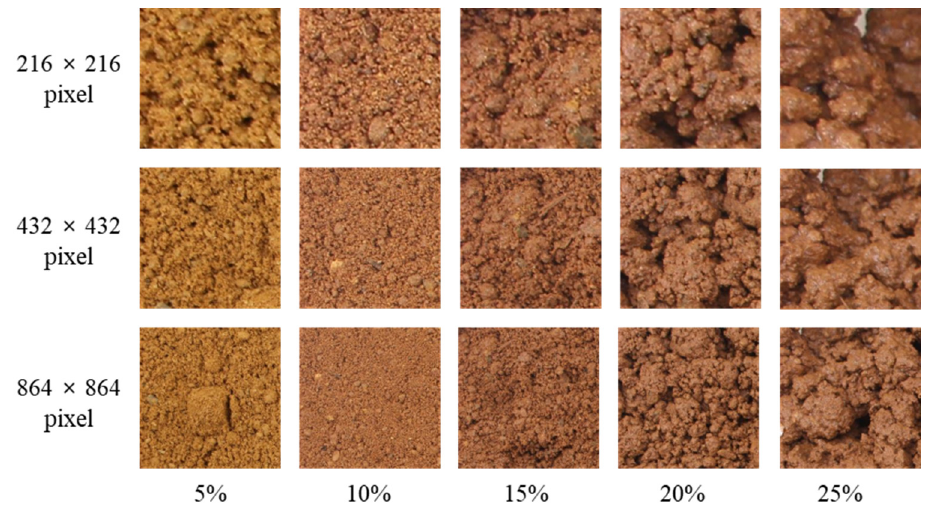
Figure 5. Sample segmented soil surface images under different soil water content conditions. Each image is a cropped image with 3 different sizes from the original soil surface image with a resolution of 5184 × 3456 pixels. Soil texture is sandy loam.